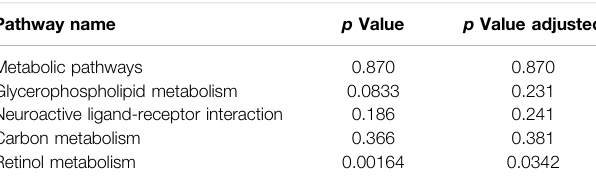
TABLE4| Pathwaysobtainedamongthecontrol,CCl 4 ,andtheSCUgroupinliver tissues samples. Pathway name p